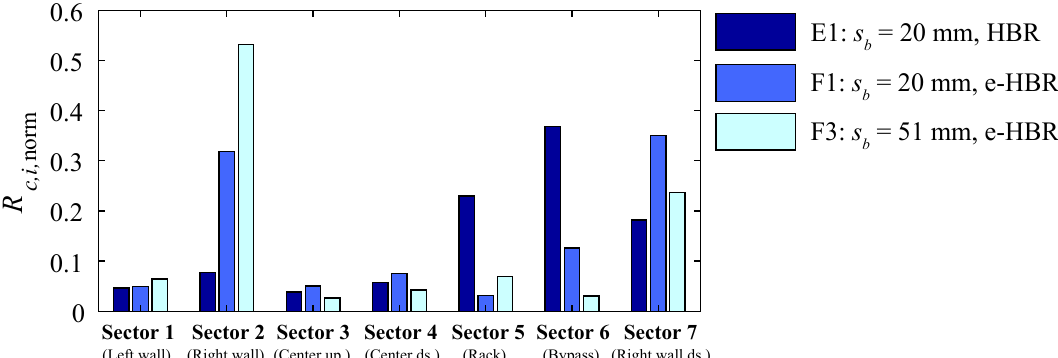
Figure 7. Normalized residence coefficient R c , i , norm of spirlin ( Alburnoides bipunctatus ) for sectors 1–7 with and without electrification for different s b